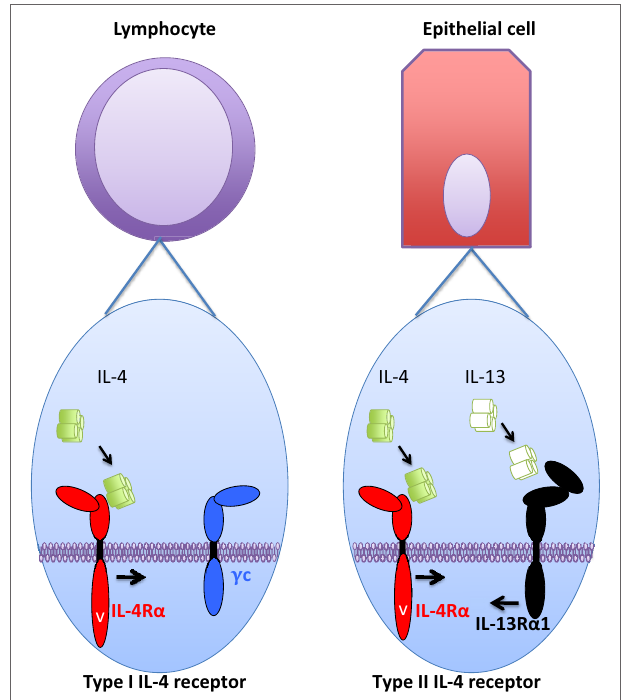
FigURe 1 | Type I and type II interleukin (IL)-4 receptor components and cellular distribution. Type I IL-4 receptor is mainly expressed in hematopoietic cells, and specifically in lymphocytes (left part) very little or no expression of type II receptor is observed. In non-hematopoietic cells, such as epithelial cells (right part), very little or no expression of type I IL-4 receptor is observed. Instead, type II IL-4 receptor is readily expressed and subsequently these cells are also responsive to IL-13 that utilizes type II IL-4 receptor, but “drives” it into opposite direction than IL-4. Myeloid cells (not pictured) fall in between these two cell types as they express both type I and type II IL-4